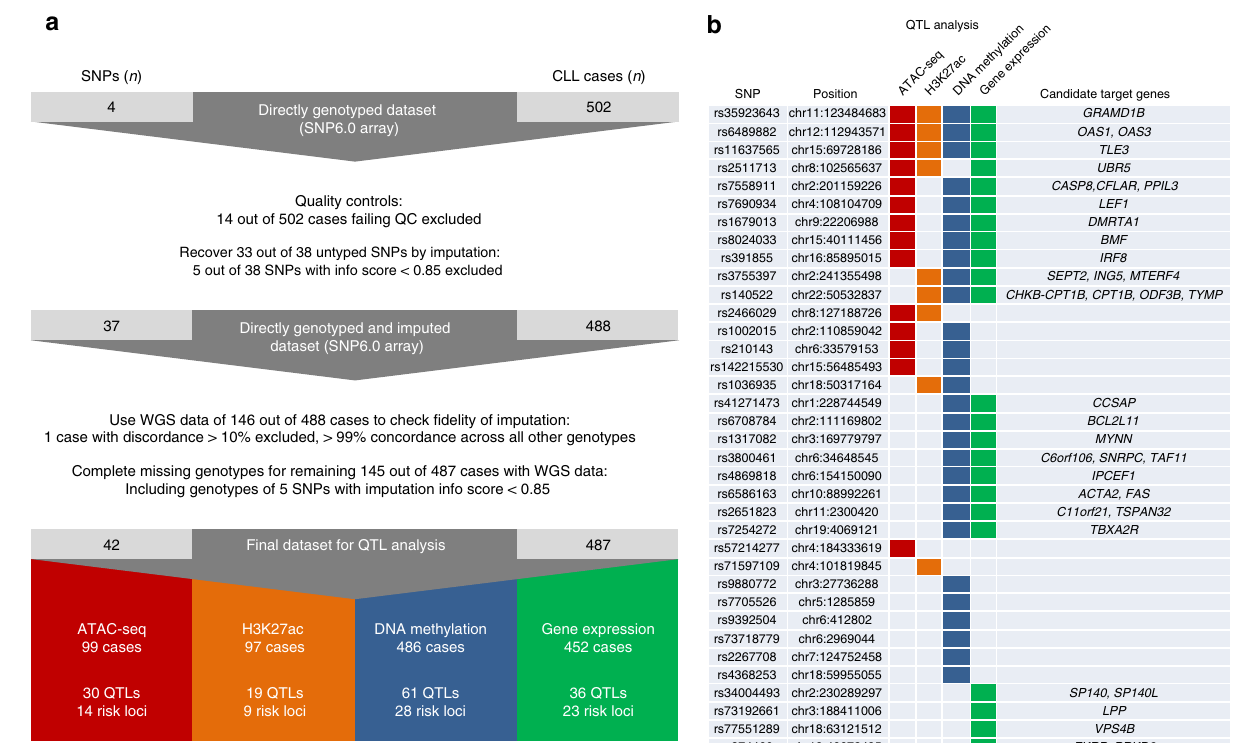
Fig. 2 Quantitative trait locus (QTL) analysis and results overview. a Work fl ow describing the generation of genotypes for 42 non-HLA risk single- nucleotide polymorphisms (SNPs) in 487 chronic lymphocytic leukemia (CLL) patients for use in QTL analyses. The genotypes were assigned using a combination of directly genotyped ( n = 4 independent SNPs) or imputed ( n = 38 independent SNPs) SNP6.0 array data (502 independent CLL patients) and whole-genome sequencing (WGS) data ( n = 146 independent CLL patients). Fourteen of the 502 CLL cases were excluded owing to non-European ancestry, excessive heterozygosity, or sample relatedness. Five of the 38 imputed SNPs were subject to poor imputation with an information measure <0.85. The imputation fi delity check using the WGS data resulted into the exclusion of one CLL case with >10% discordance between the imputed and WGS data. In the lower part of the panel, summary results for each type of analysis are shown. b Per locus overview of QTL analysis results. Loci are denoted by their respective sentinel SNPs (with their location in GRCh38) and shaded boxes indicate the presence of ≥ 1 signi fi cant QTL at false discovery rate <0.05 for each of the four layers analyzed: assay for transposase-accessible chromatin using sequencing (QTLs marked by dark red shading); H3K27ac (orange); DNA methylation (blue); gene expression (green). In addition, on the right, the candidate target genes identi fi ed by expression QTL analysis are Datasets . Whole-genome sequencing (WGS) and SNP6.0 array data (Thermo Fisher Scienti fi c) of, respectively, 146 and 502 patients were obtained from Puente et al. 14 . Chromatin state segmentations (200bp bins) of 7 CLLs and 15 normal B- cell samples as well as variance-stabilized (vst) data signals of H3K27ac and ATAC- seq determined by DESeq2 (corrected for signal proportion of tags (SPOT) score) (97 and 99 CLL patients, respectively) were derived from Beekman et al. 12 (http:// resources.idibaps.org/paper/the-reference-epigenome-and-regulatory-chromatin- landscape-of-chronic-lymphocytic-leukemia). DNA methylation data of 486 CLLs (Illumina 450k arrays) and GC-RMA normalized gene expression data of 452 CLL patients (GeneChip Human Genome U219 arrays) were derived from Puente et al. 14 .